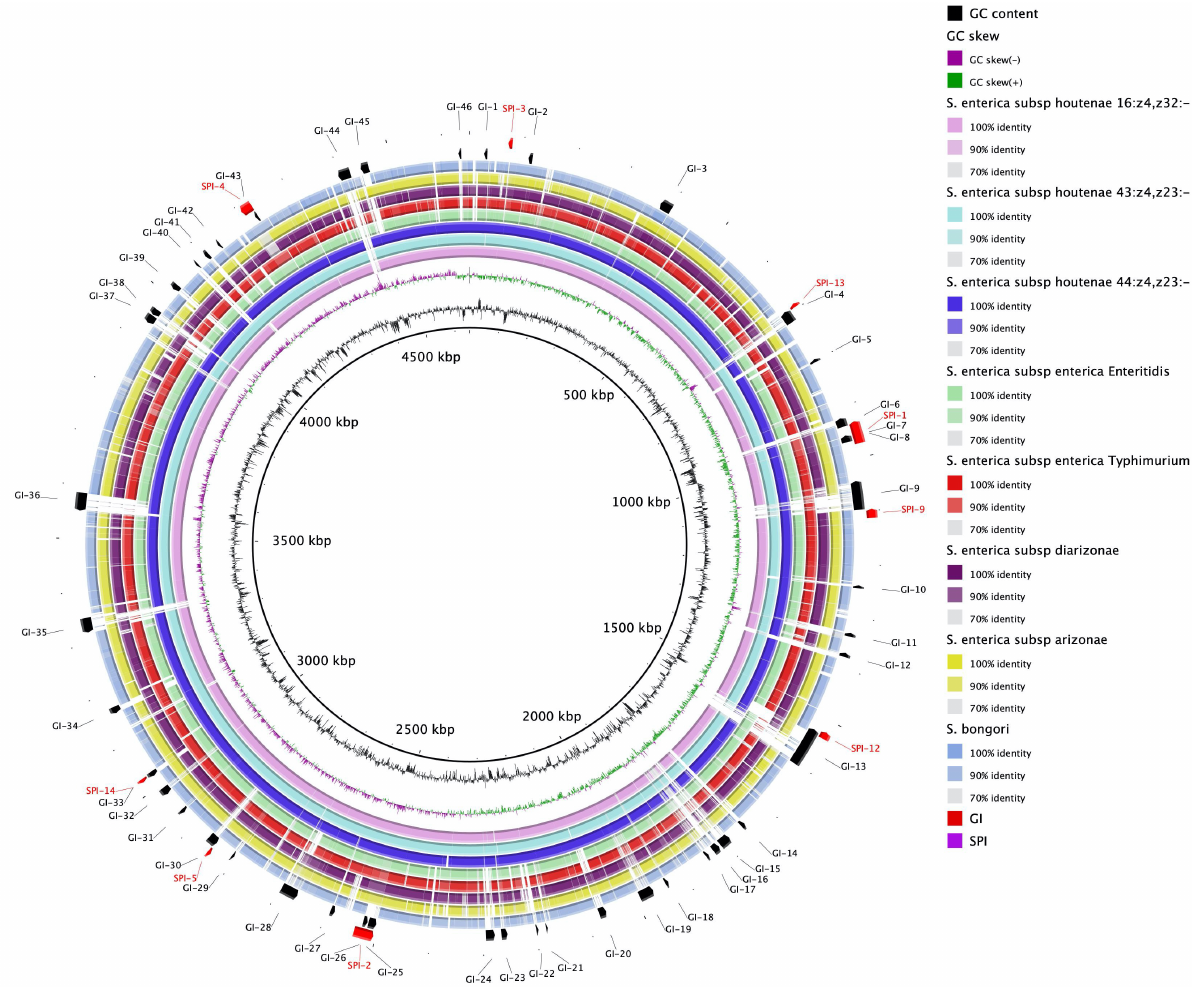
Figure 2. Blast Ring Image Generator (BRIG) diagram showing the complete genomes of Salmonella spp. strains, with genome of strain 20-369 as a reference. The outer circle contains genomic island regions (black) and Salmonella Pathogenicity Island (SPI) (red) of strain 20-369. GC content is also shown in the